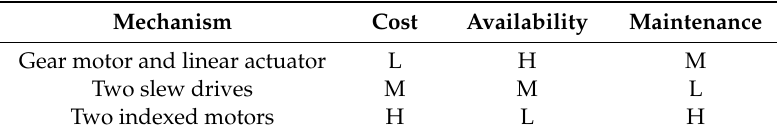
Table 3. Actuator selection for mechanism tracking.